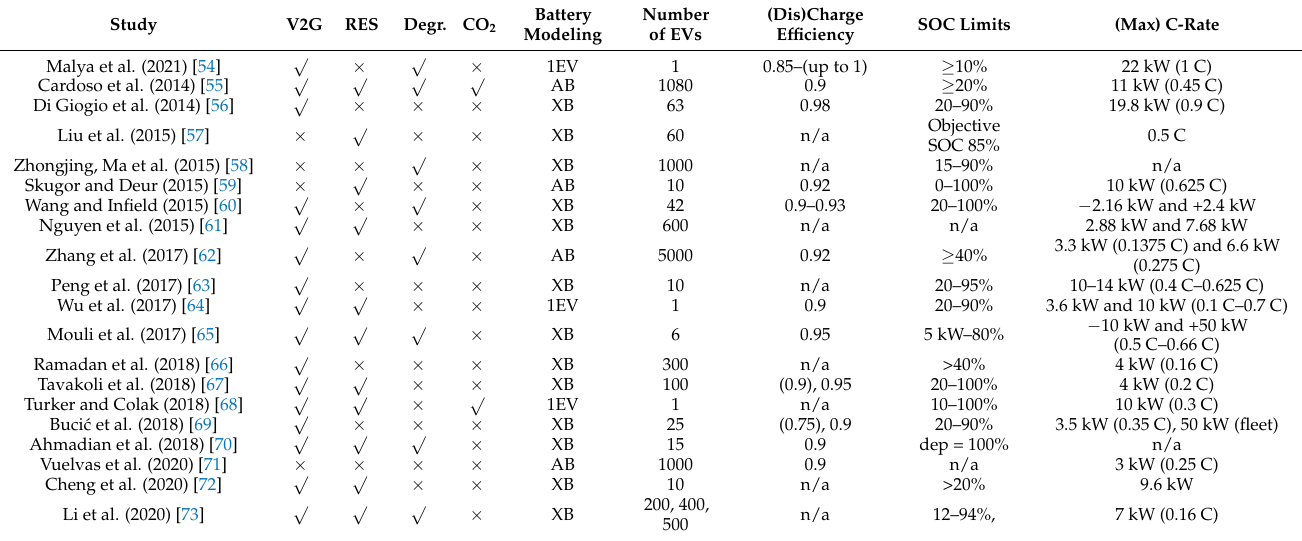
Table 1. Battery modeling and charging parameters found in the